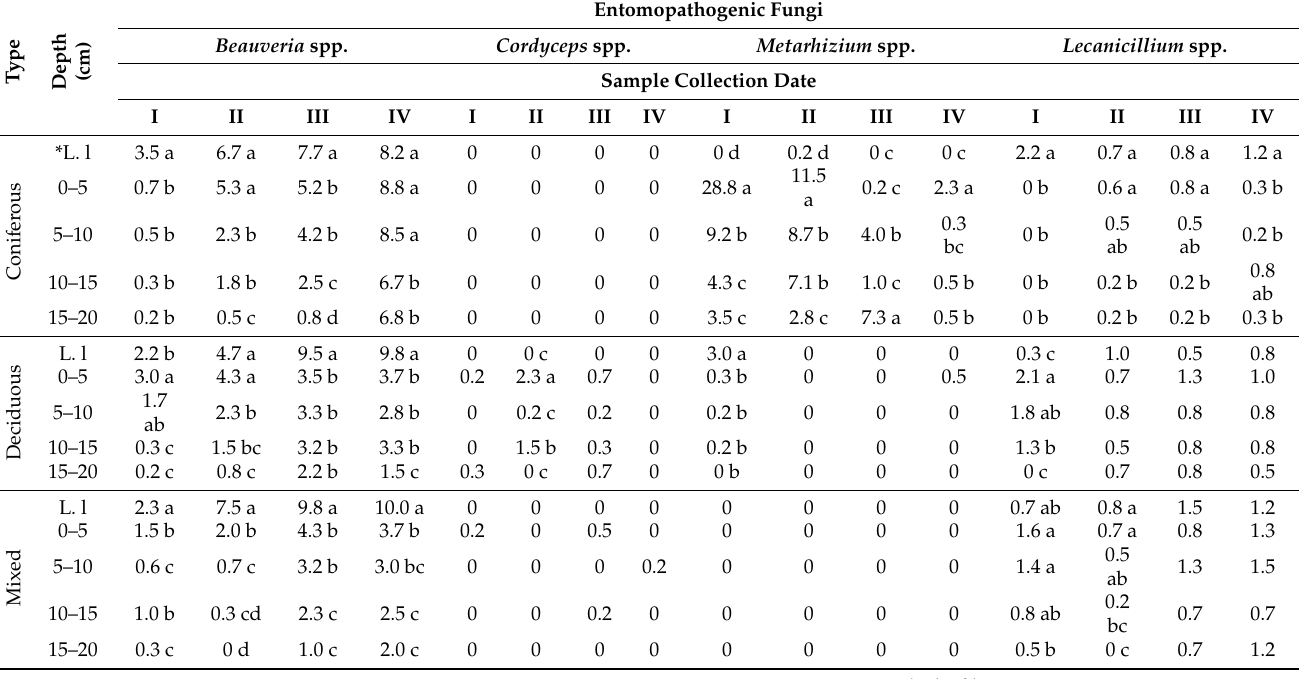
Table 1. Mean densities of entomopathogenic fungi (CFUs × 10 3 /g soil or leaf litter) from the Golice locality; lowercase letters represent statistically significant differences between CFUs among the sampling depths (leaf litter vs. other layers) at each sampling date and forest type.